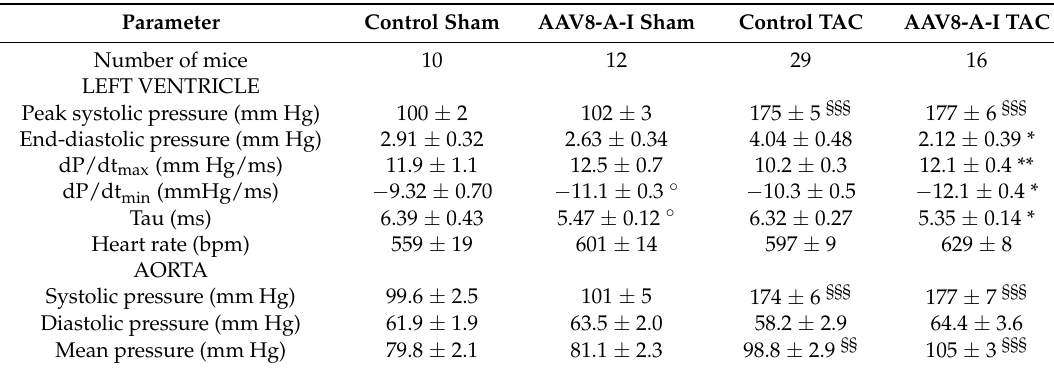
Table 4. Hemodynamic parameters in C57BL/6 LDLr − / −